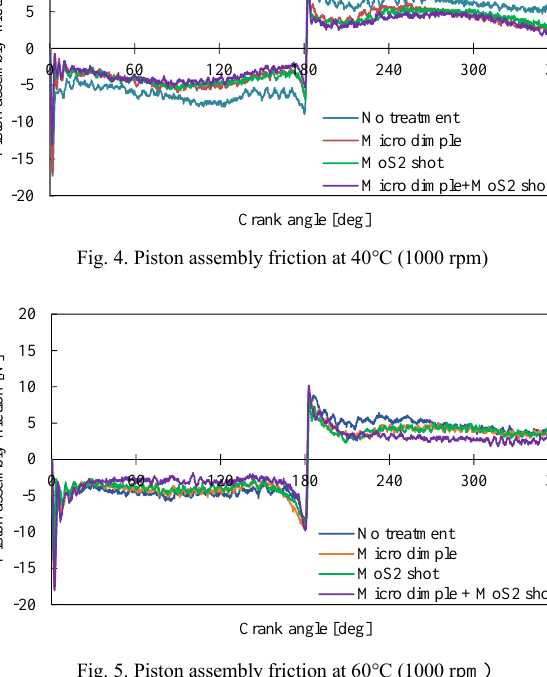
Fig. 8. Stribeck diagram in micro dimple treatment (1000 rpm)